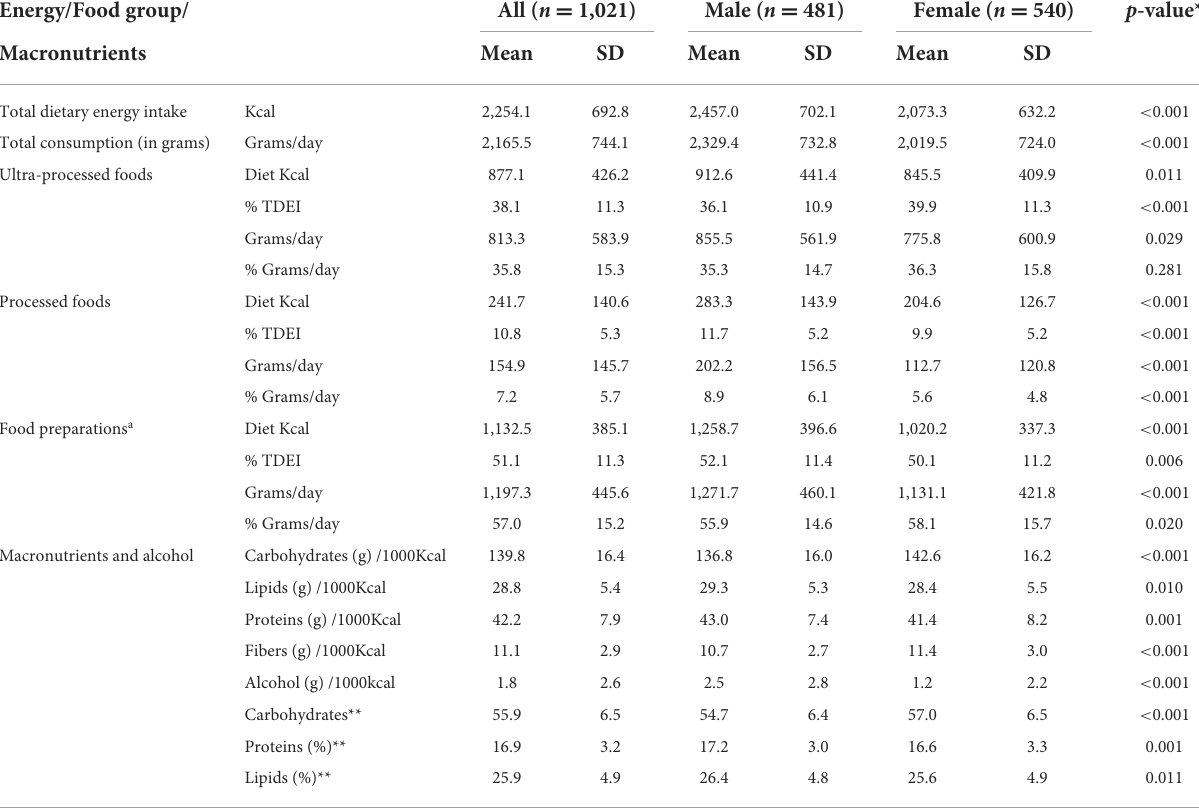
TABLE 2 Food group consumption according to the NOVA classification and macronutrients and alcohol consumption by 23–25-year old participants (2002/2004) of the 1978/1979 Ribeirão Preto birth cohort study (São Paulo, Brazil). Energy/Food